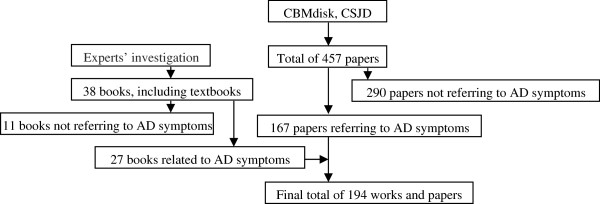
Modern literature search process.